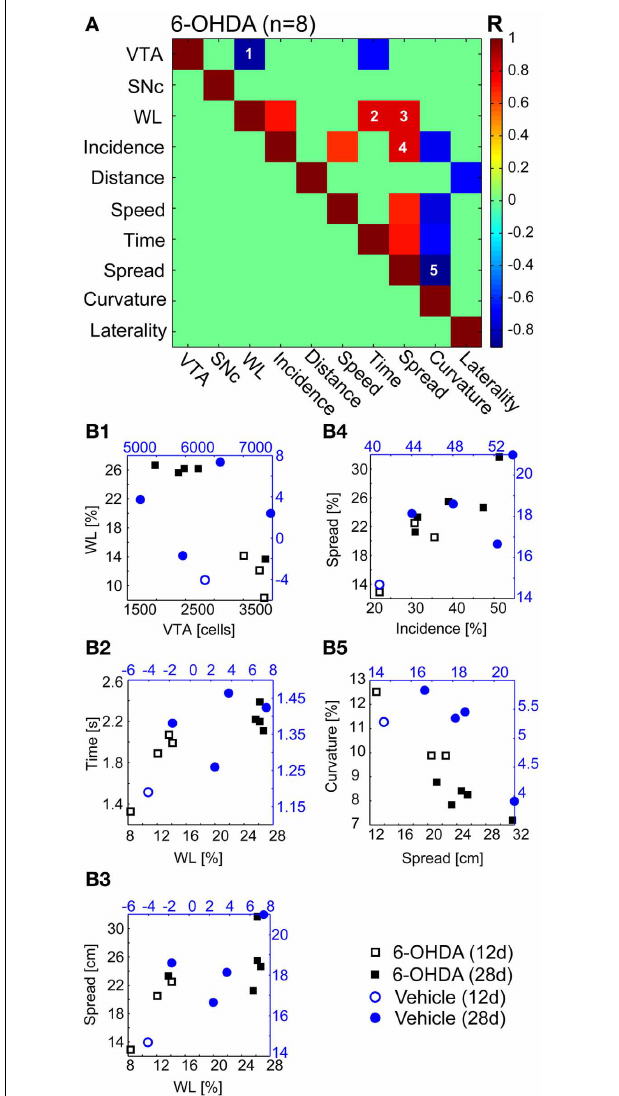
FIGURE 6 | Bootstrap regressions. (A) Independent bootstrap regressions ( n = 55) of the 6-OHDA group ( n = 8 animals). The bootstrapping R -value is color-coded and clipped for correlations with P > 0 . 1 after FDR-correction (green fields). (B1–5) Correlations with P < 0 . 05 after FDR-correction. Open and filled markers indicate rats from 12 to 28 days subsets, respectively. 6-OHDA,